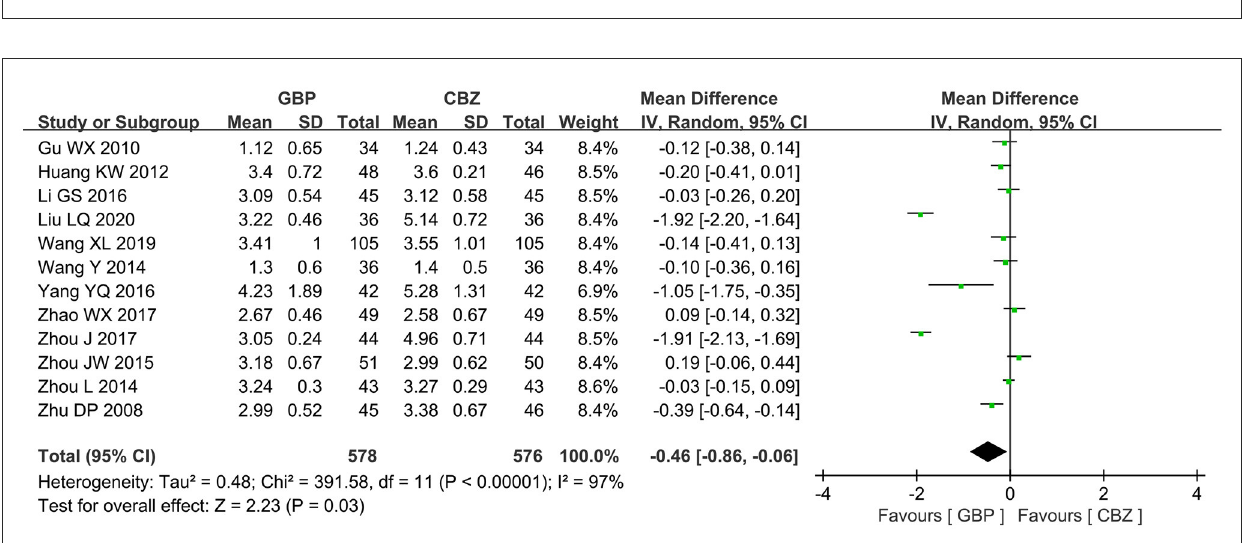
FIGURE4 Forest plot of GBP vs. CBZ: VAS score. GBP, gabapentin; CBZ,